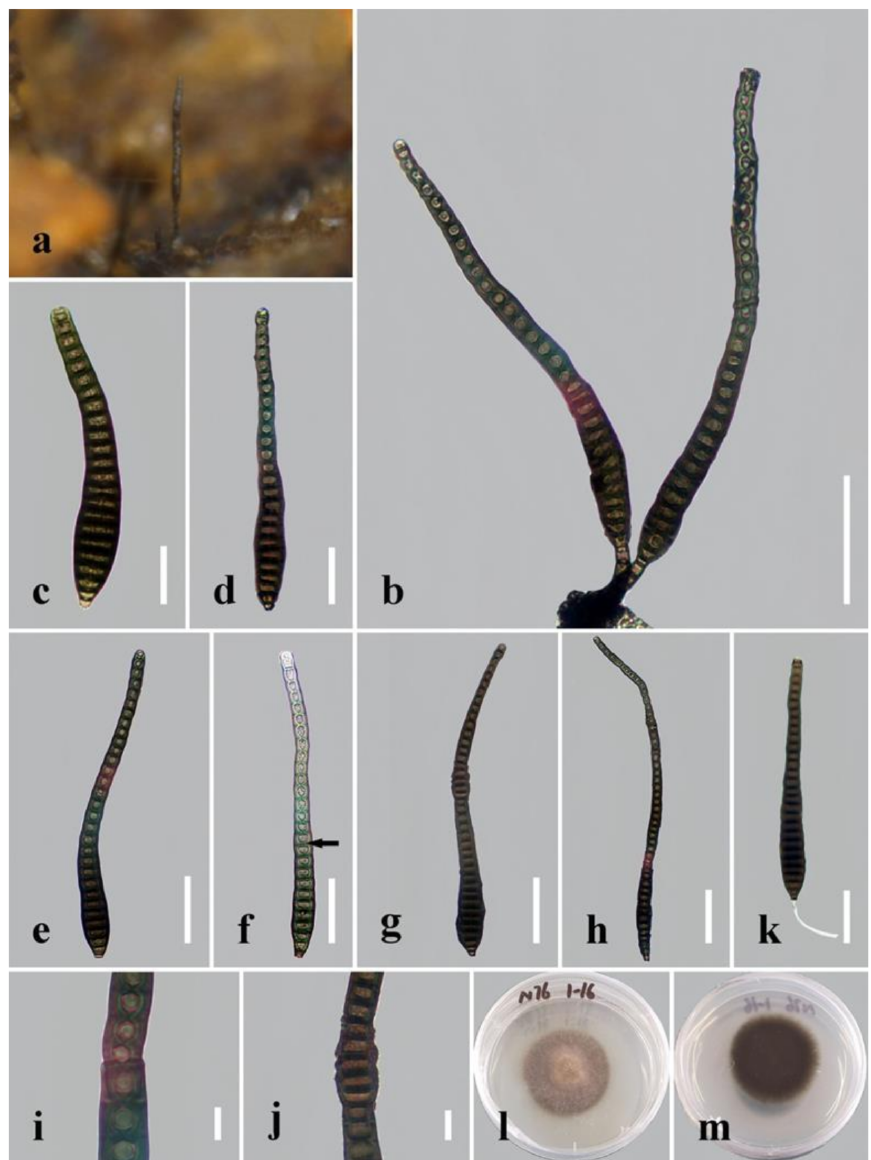
Figure 6. Distoseptispora clematidis . ( a ) Colonies on natural substrate. ( b ) Conidiophores with conidia. ( c – h ) Conidia. The arrow in f points to a gap in the middle of the septum, which indicates the distosepta. ( i , j ) Portions of conidia with percurrent proliferation in the middle of conidia. ( k ) Ger- minated conidium. ( l ) Colony on PDA (from front). ( m ) Colony on PDA (from reverse). Scale bars: ( b , g – h ) 50 µ m; ( c , d ) 10 µ m; ( i , j ) 5 µ m. Distoseptispora crassispora R. Zhu & H. Zhang, sp. nov. (Figure